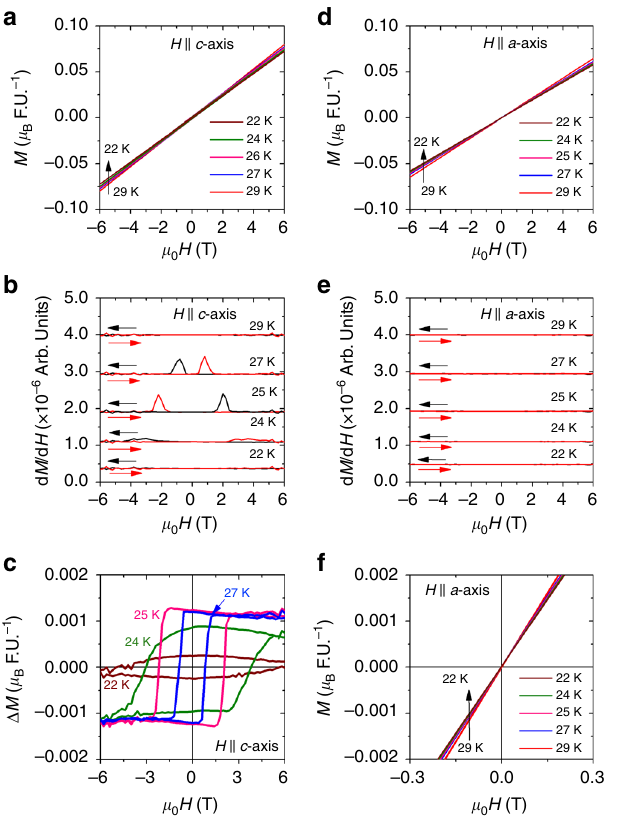
Fig. 2 Magnetization of CoNb 3 S 6 . a M vs H measured with magnetic fi eld applied along the c -axis. b d M /d H vs H for magnetic fi eld applied along the c -axis. The black (red) curves represent d M /d H for decreasing (increasing) H . c Ferromagnetic moment ( Δ M ) along the c -axis obtained by subtracting the antiferromagnetic background from the measured M vs H presented in a . d M vs H for magnetic fi eld applied along the a -axis. e d M /d H vs H for magnetic fi eld applied along the a -axis. The black (red) curves represent d M /d H for decreasing (increasing) H . f Low fi eld M vs H measured with magnetic fi eld along a -axis. d M /d H plots in b and e are shifted by a constant factor for clarity CoNb 3 S 6 : (1) non-collinear, non-coplanar or other complex magnetic textures, or (2) interplay of electronic and magnetic degrees of freedom.